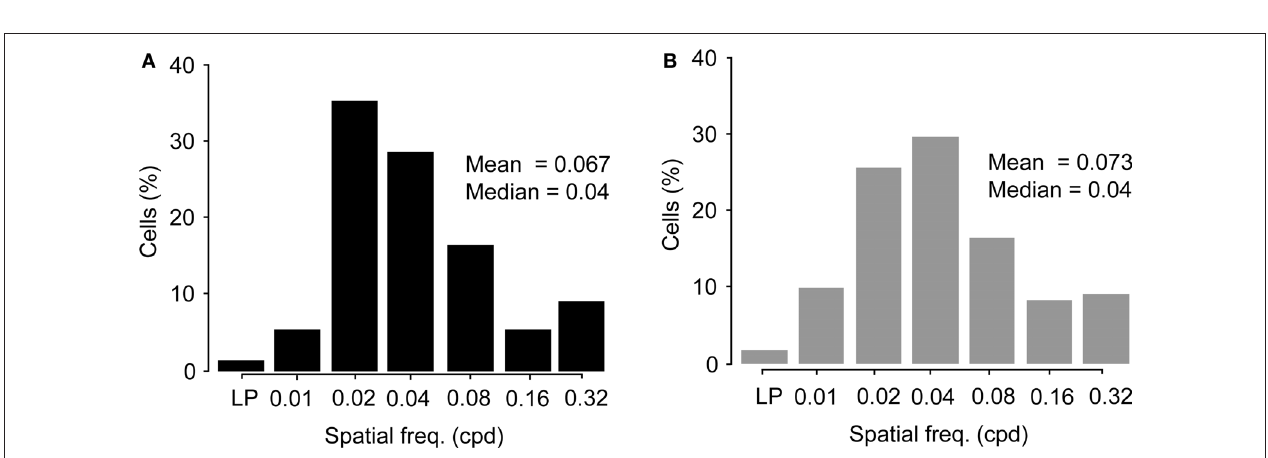
FiGure 6 | The orientation tuning (polar plots) and normalized responses to various spatial frequencies presented at the preferred orientation (bar plots) of (A) 10 Wfs1 ( + ) (shown in black) and (B) 10 unidentified neurons (gray). Values against polar plots indicate the maximum scale of the polar plot in fraction ∆ F / F .